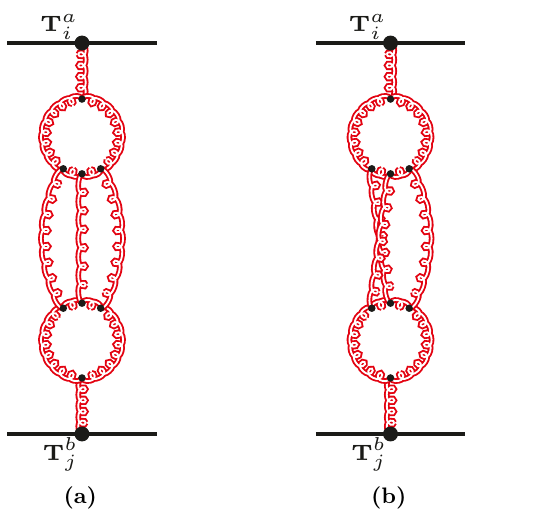
Figure 7. Diagrammatic representation of a) h ψ j, 1 | H 3 → 1 H 1 → 3 | ψ i, 1 i D in eq. (4.30a) and b) h ψ j, 1 | H 3 → 1 H 1 → 3 | ψ i, 1 i X in eq.